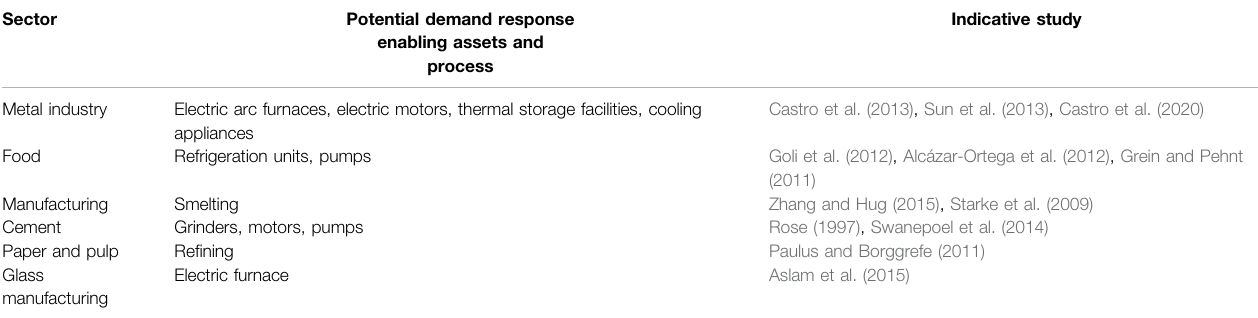
TABLE 5 | Industries with high potential of DR